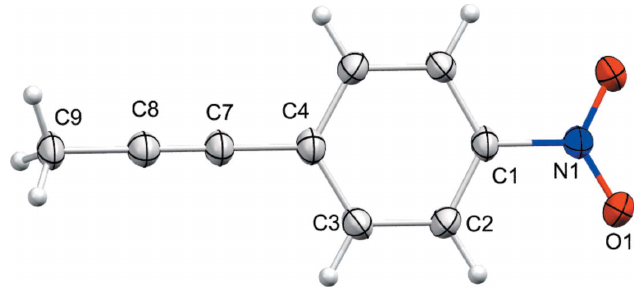
Figure 1 The title molecule, 1 , with 50% probability ellipsoids. Unlabelled atoms are generated by the symmetry operation 1